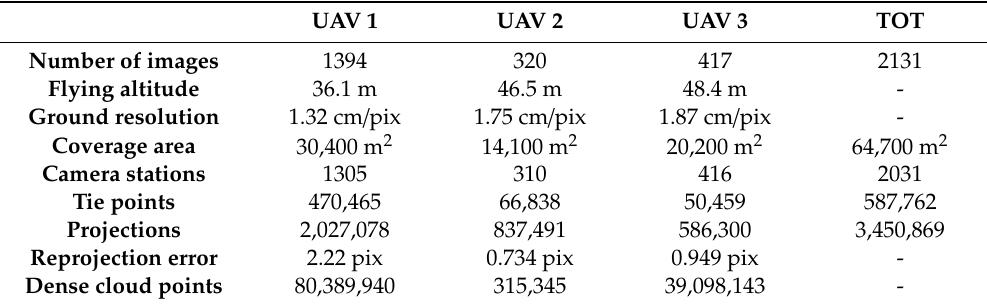
Table 1. Data related to the UAV surveys and point